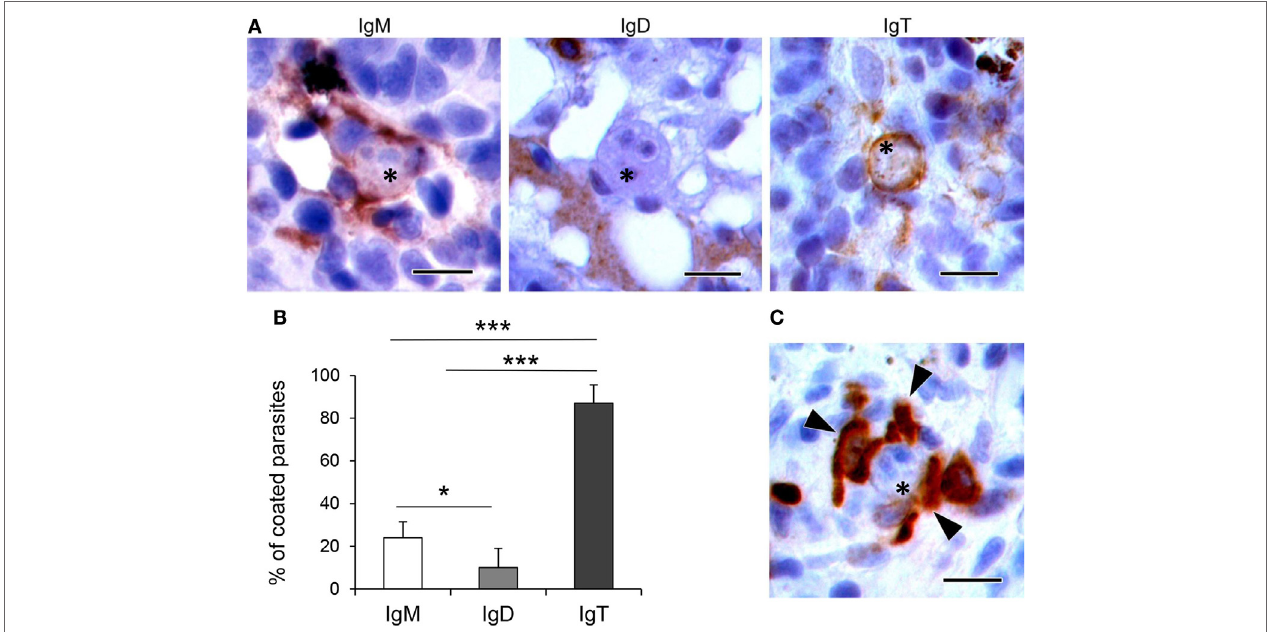
FigUre 5 | Coating of Tetracapsuloides bryosalmonae with host Igs. (a) Representative images showing parasites (indicated with asterisks) in the trunk kidney of rainbow trout coated with IgM, IgD, and IgT. Note the strong IgM and IgT immunoreactivity surrounding parasite stages, compared with low IgD immunoreactivity. Scale bars = 10 µm. (B) Mean percentage of parasites coated with each Ig. The presence and absence of IgM, IgD, and IgT immunoreactivity was recorded in 100 parasites from different individual fish with swelling grades from 1 to 4 ( n = 6), and statistically significant differences between parasite coating with the different Ig calculated by a one­way ANOVA followed by two­tailed Student’s t ­test (* P < 0.05 and *** P < 0.005). (c) Representative image showing several IgT + cells (indicated with arrowheads) in close contact with a parasite (indicated with an asterisk). Scale bar = 10